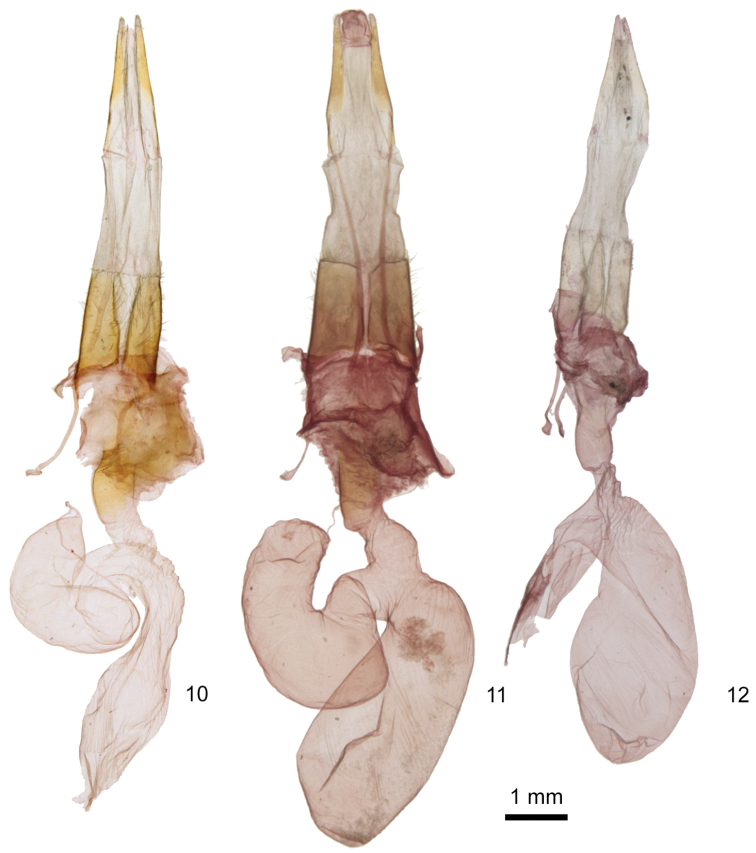
Rhabdorthodes female genitalia 10R.pattersoni11R.durango12R.petersoni.